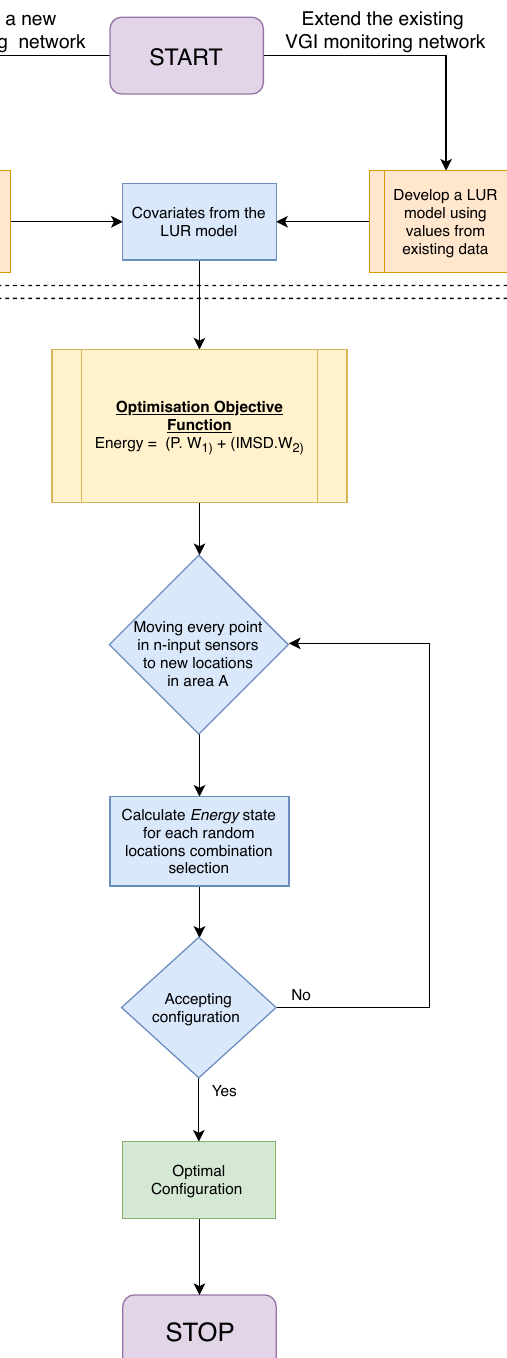
Figure 3. Overall flow of the optimisation